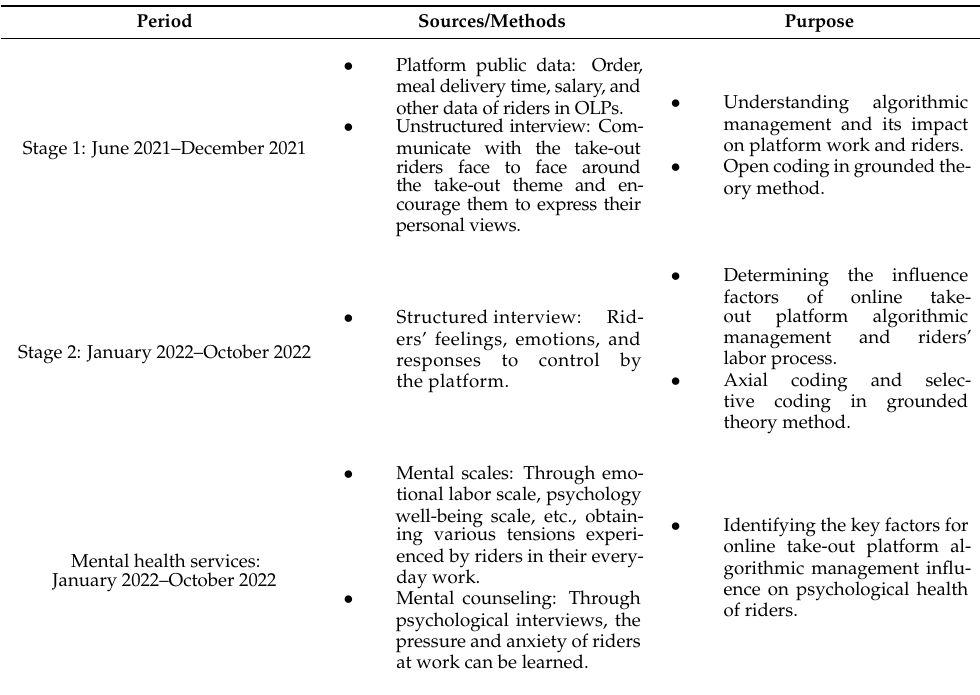
Table 1. Data collection in each stage.